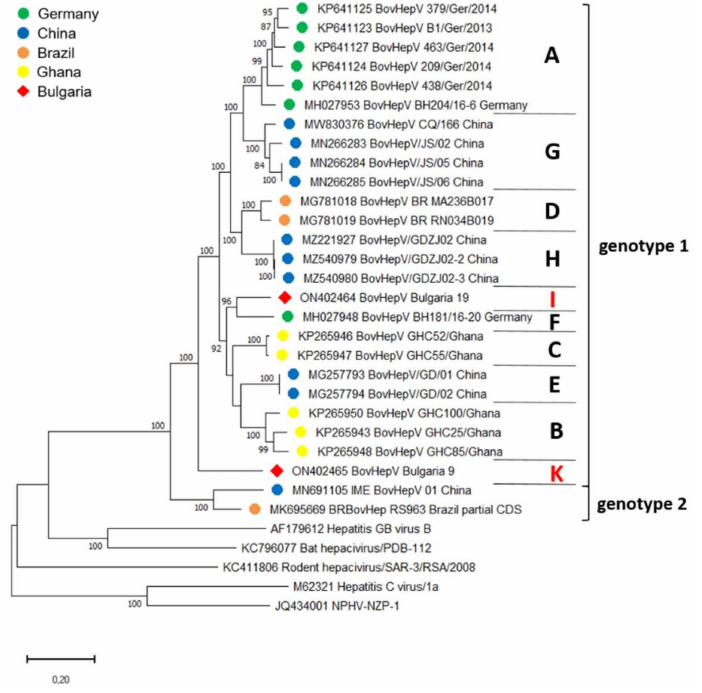
Figure 3. Maximum Likelihood phylogenetic tree based on complete BovHepV polyprotein coding sequences deposited in GenBank. Only a partial sequence of 6102 nucleotides has been reported for BovHepV sequence BRBovHep RS963 Brazil. Bootstrap values <70% are not shown. BovHepV subtypes (in capitals) and genotypes are indicated on the right. Color codes of BovHepV sequences specify the country of origin. The newly discovered Bulgarian sequences are marked with a red rhombus and the newly described subtypes I and K are depicted in red letters on the right side. Scale bar indicates nucleotide substitutions per